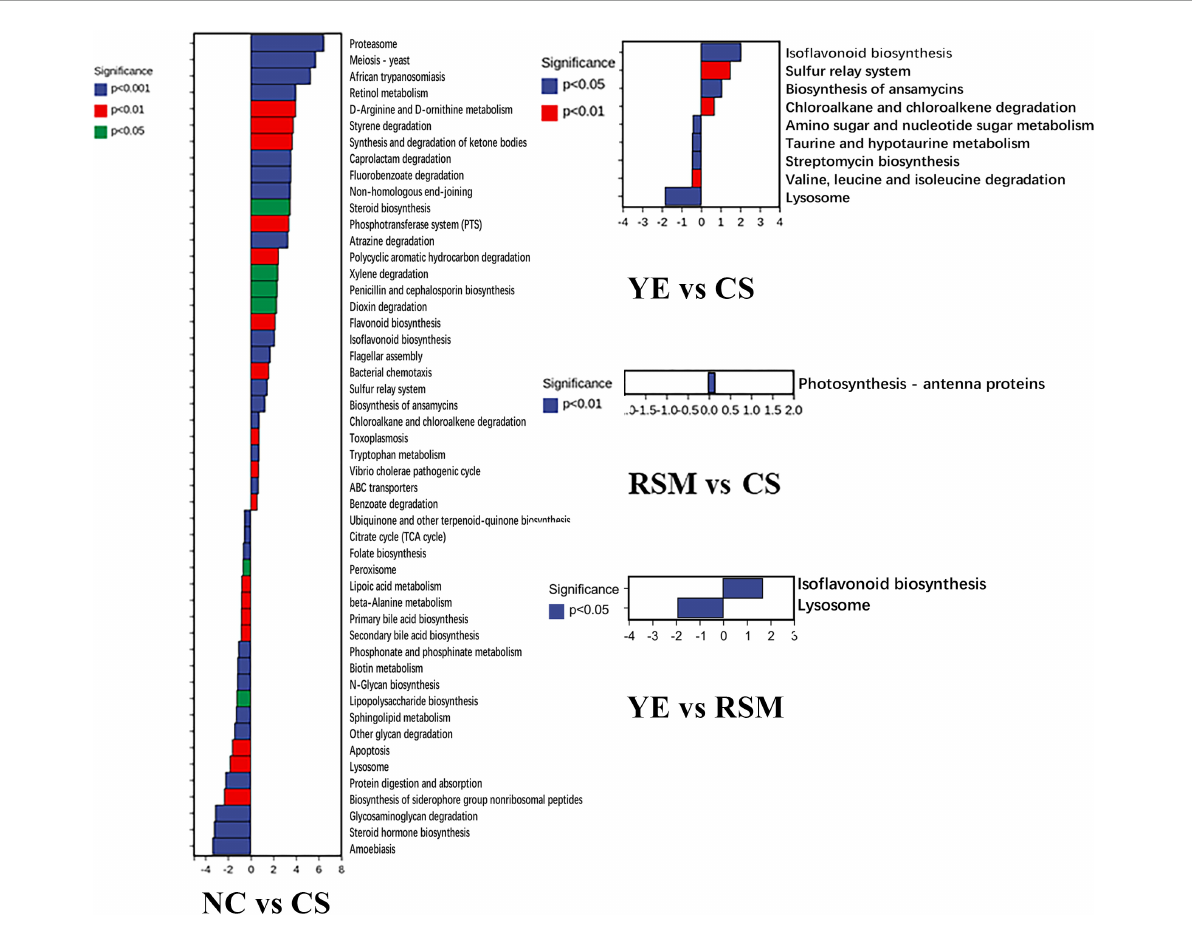
FIGURE6 Changes in metabolic pathways of CS and two algal oils administered. Significant differences are indicated as P < 0.05, P < 0.01, P <